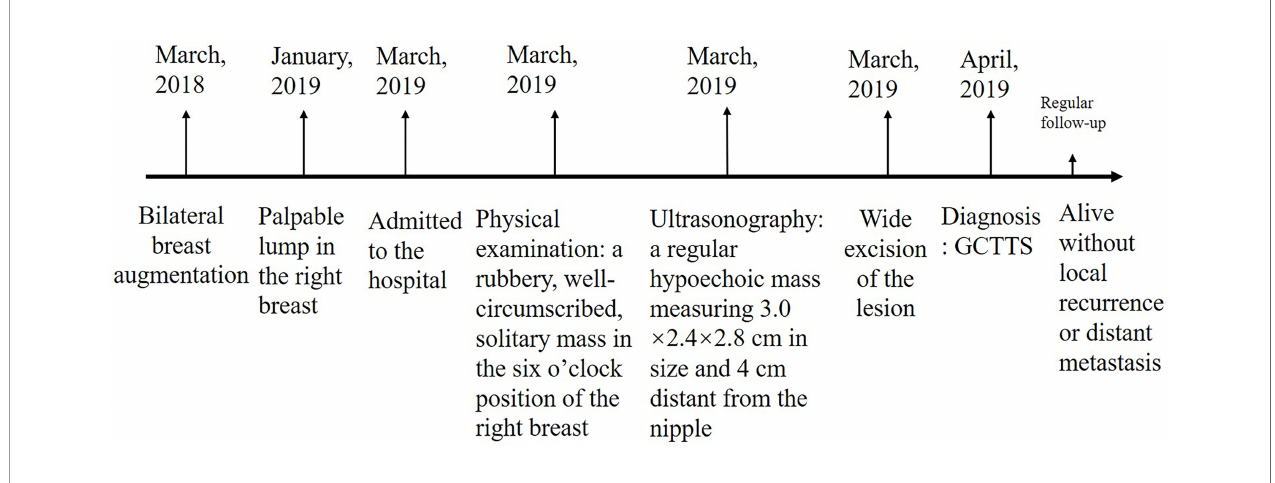
FIGURE 2 | Timeline.